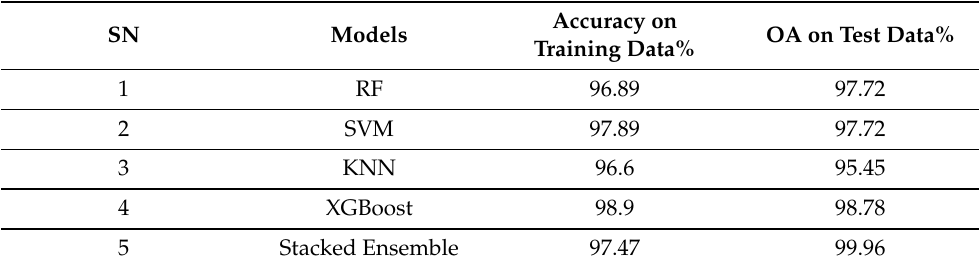
Table 4. Overall accuracy of the base and ensemble